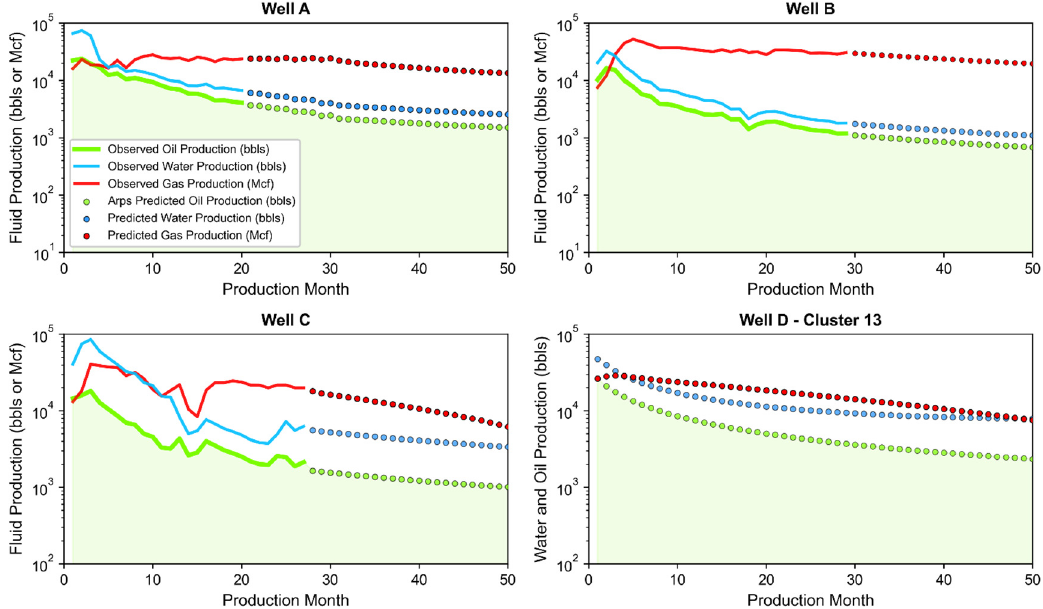
Figure 13. Gas and water prediction forecast using the joint associated fluid production model lev- eraging oil forecast outlooks generated from the Arps model.